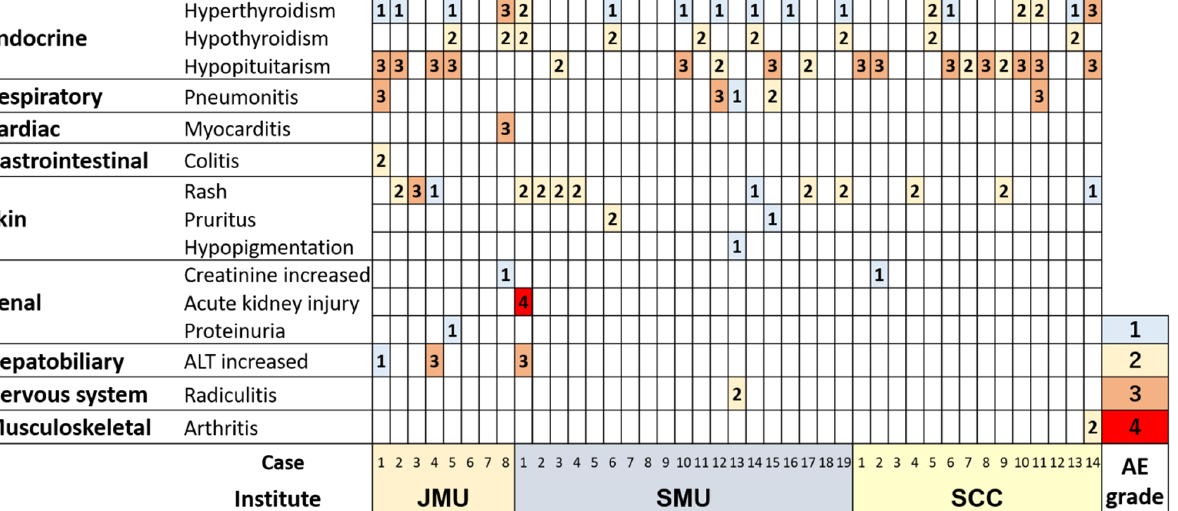
Figure 4. Co-occurrence of endocrine irAEs. Co-occurrences and sequences of hyperthyroidism with hypopituitarism ( a ),( b ) and primary hypothyroidism ( c ),( d ). 3.7. Association between Endocrine and Non-Endocrine irAEs Endocrine irAEs sometimes co-occurred with non-endocrine irAEs other than skin- related irAEs (Figure 3). The incidence of irAEs other than skin-related irAEs increased with the number of endocrine irAEs per patient (7/30/41% of any grade, p = 0.10; 0/10/35% of ≥ Grade 3, p = 0.027 in patients with zero/one/and two or more endocrine irAEs; Figure 5a,b). However, the number of endocrine irAEs was not statistically associated with skin- related irAEs (Figure 5c,d).